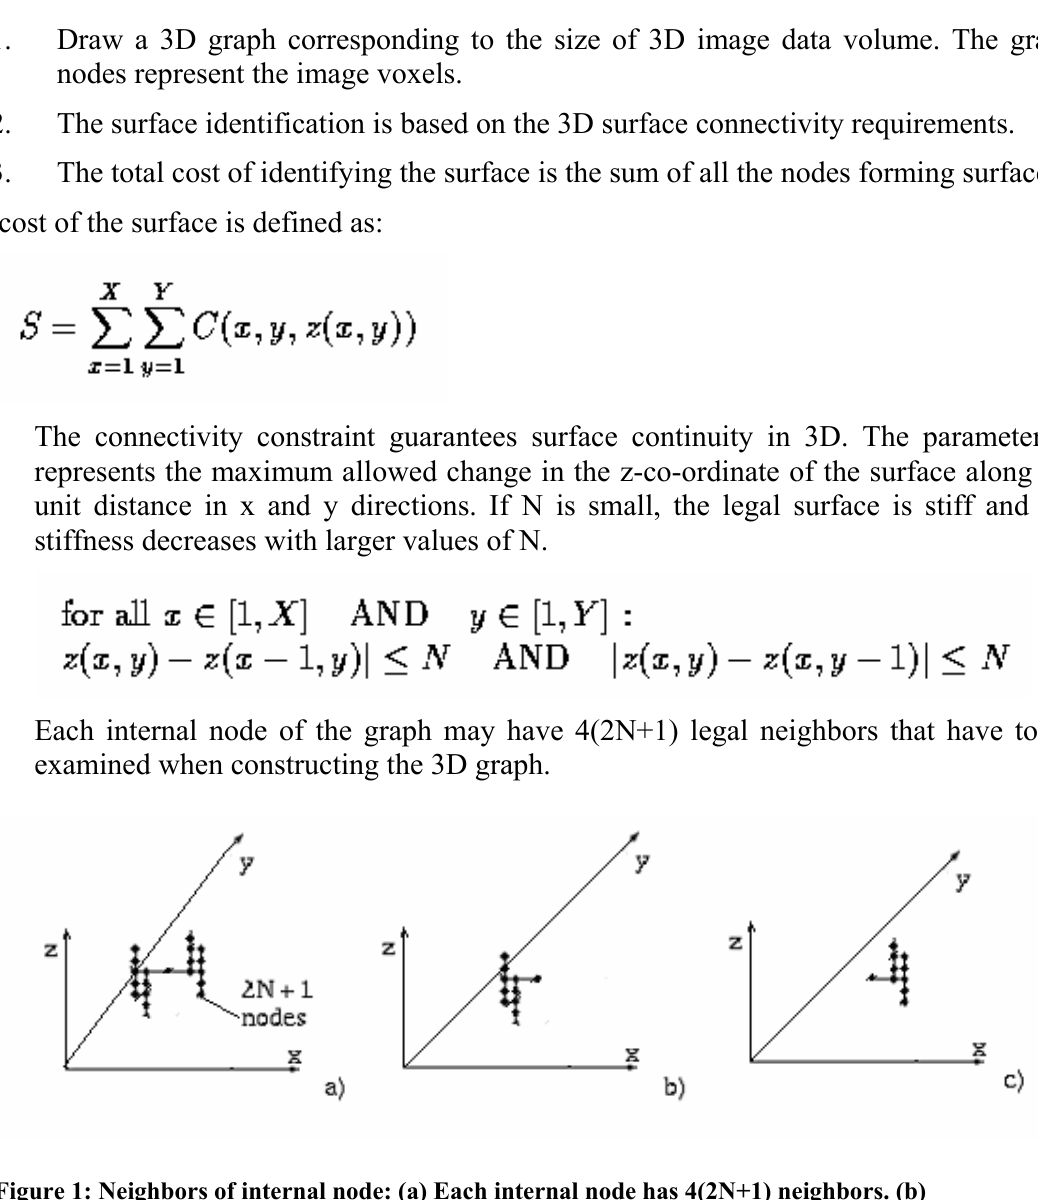
Figure 1: Neighbors of internal node: (a) Each internal node has 4(2N+1) neighbors. (b) Immediate predecessors (c) Immediate